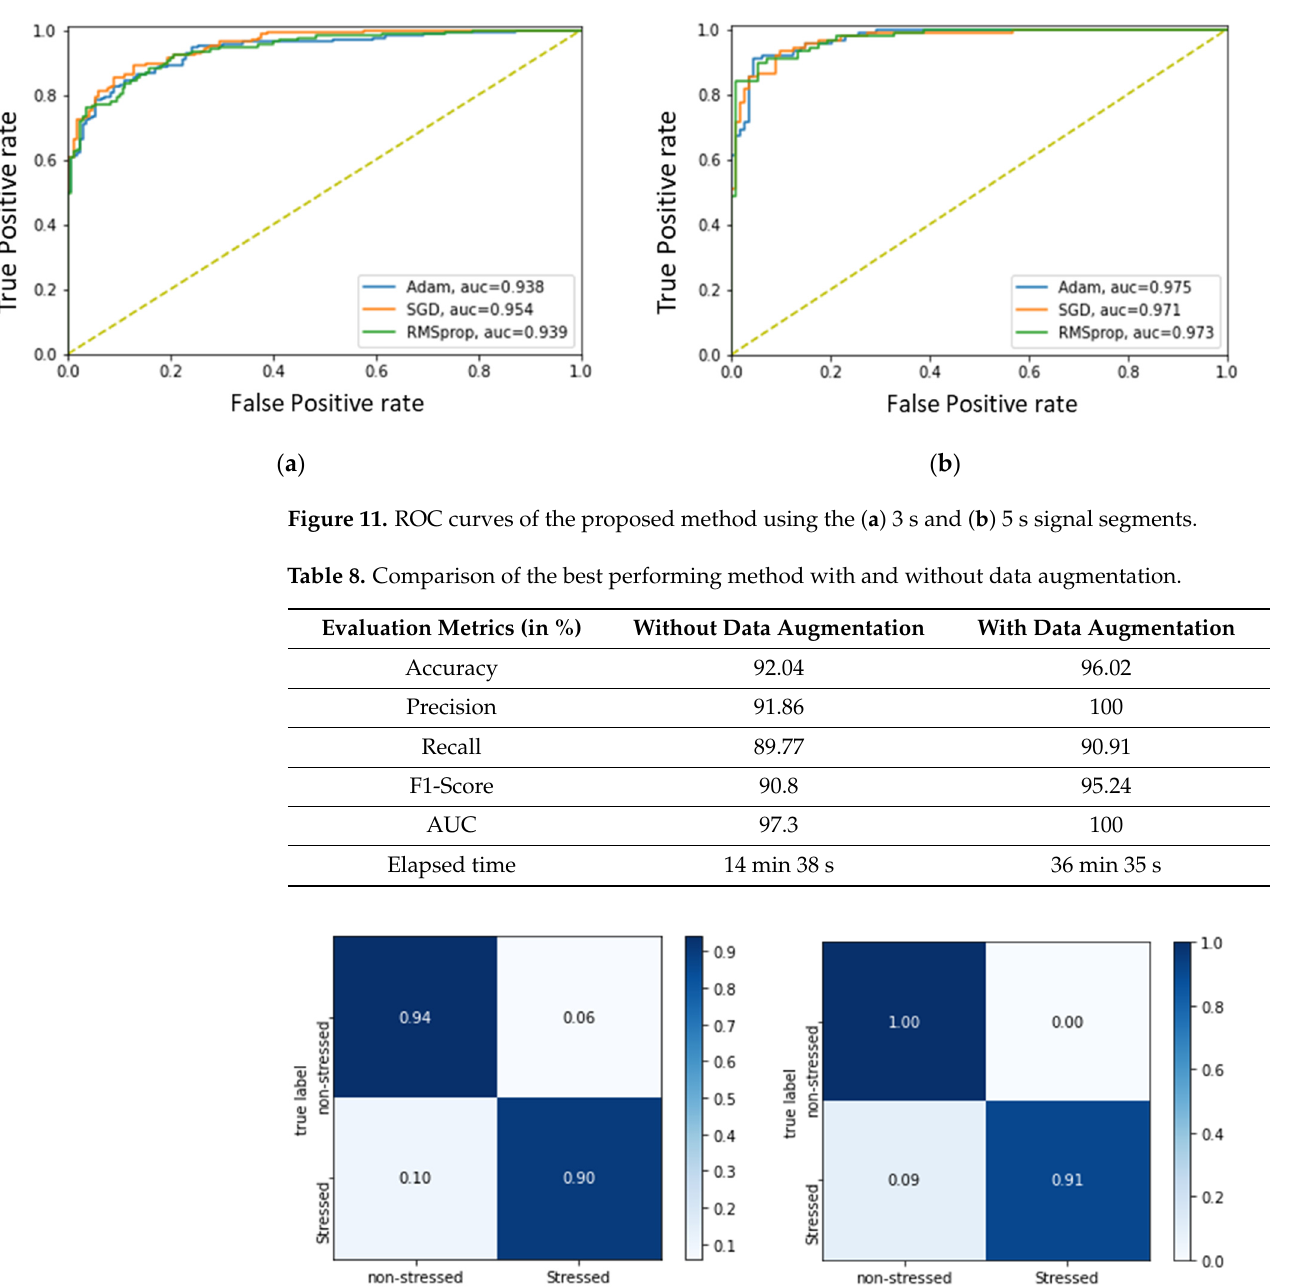
Figure 13. ROC analysis for the combination of the best-performing signal segment (5 s) and opti- mizer (RMSprop) are shown before and after data augmentation. It has been challenging to compare the results of this study with those of other meth- ods due to the unique nature of the dataset used. We compared our results with those of other state-of-the-art CNN transfer learning methods, including GoogleNet [59], ResNet- 50, ResNet-101 [60], and DenseNet-201 (Table 9) [61]. To ensure a fair comparison, all ex- perimental settings were the same as those used in our proposed CNN model. In short, the proposed CNN method was more effective for mental stress detection compared to the CNN-based transfer learning methods. Additionally, our network resulted in shorter training time. Table 9. Comparative analysis with existing CNN models. Models